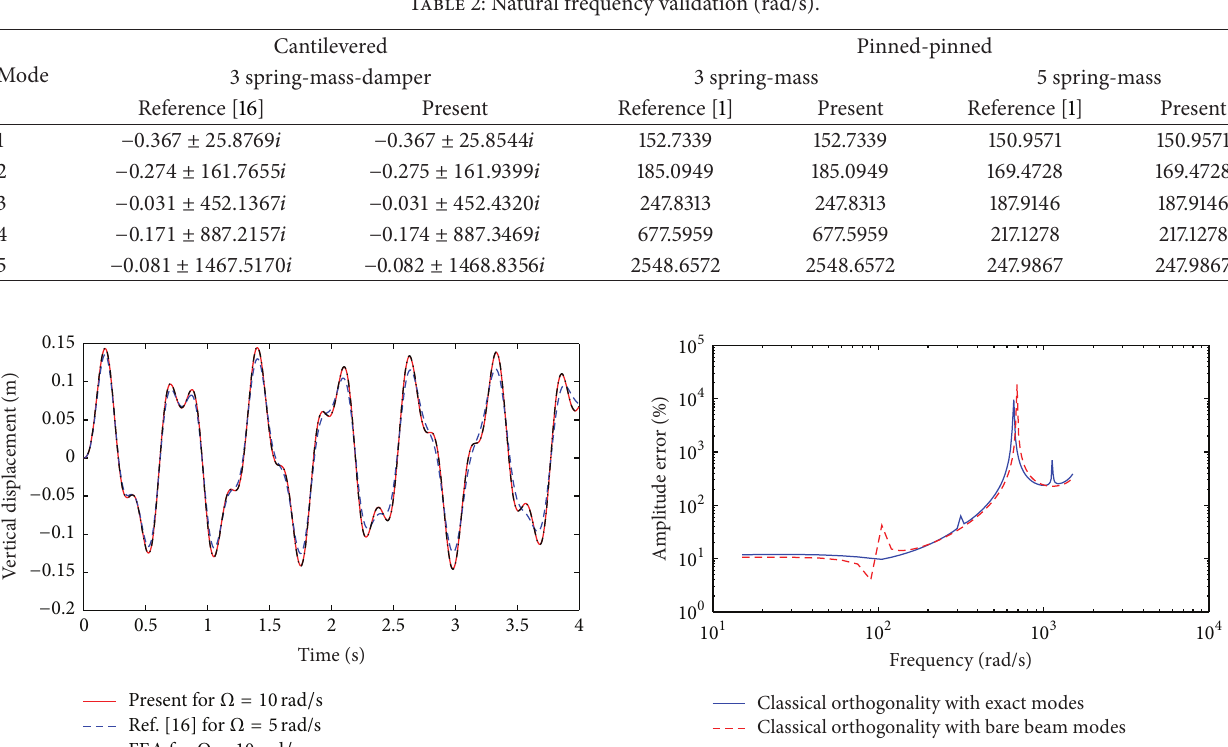
Table 2: Natural frequency validation (rad/s).